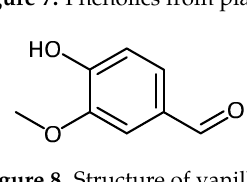
Figure 7. Phenolics from plants.